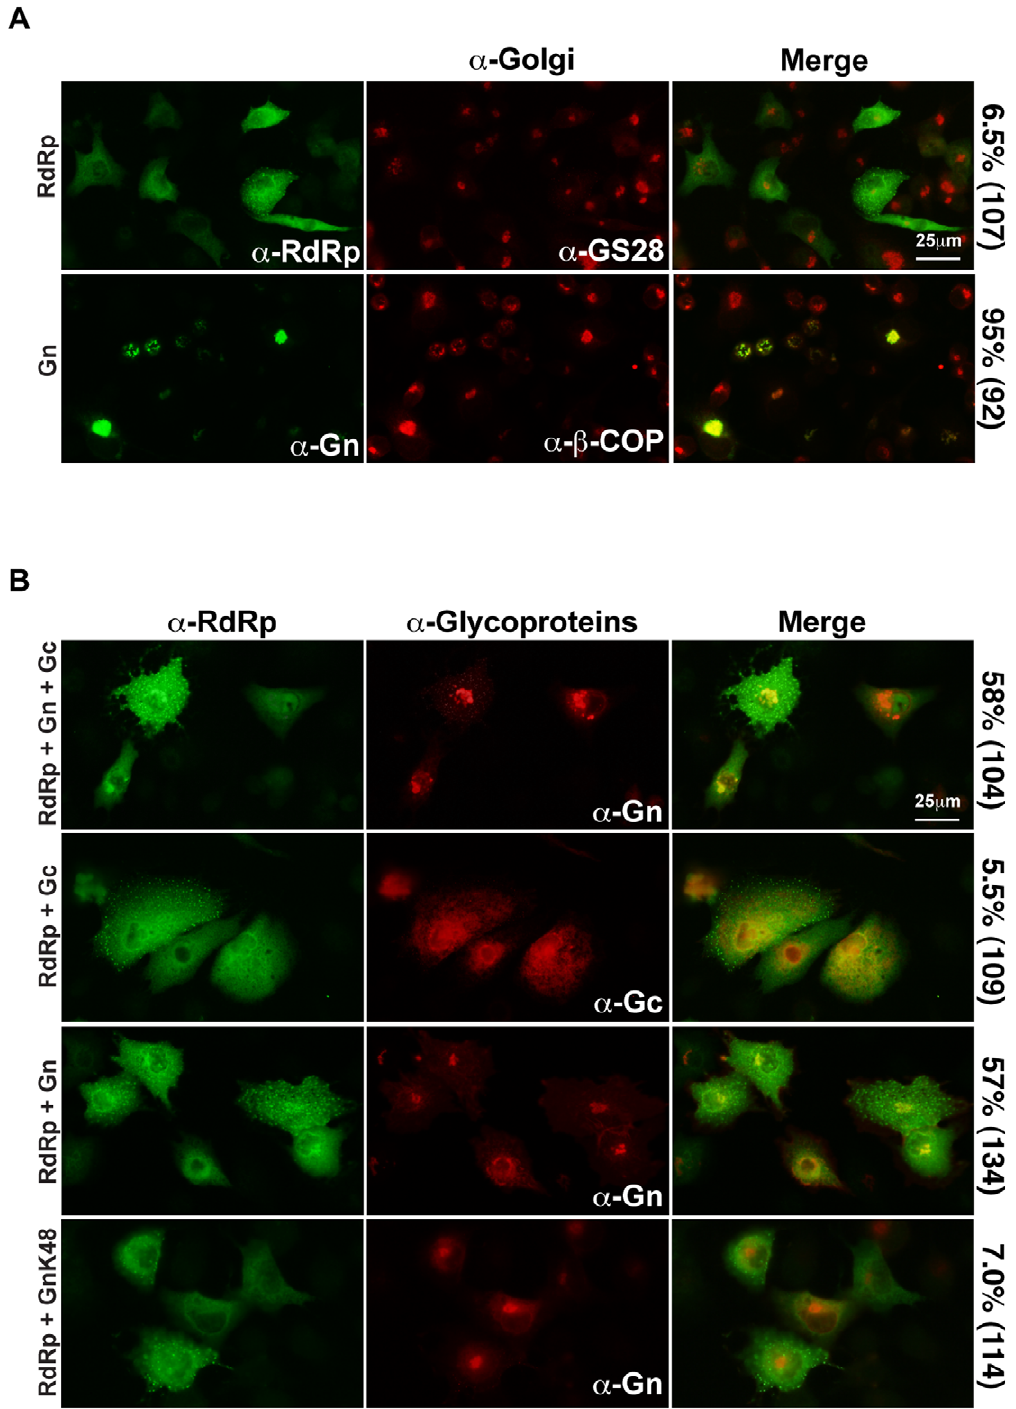
Figure 3. Gn recruits RdRp. A. BSR-T7/5 cells were transfected with pRdRp or pGn, and the proteins were visualized with anti-RdRp and anti-Gn, respectively (green channel). Cellular resident Golgi apparatus proteins, GS-28 or b -COP were also labeled (red channel). Percentage of cells displaying co-localization of viral proteins with resident Golgi proteins is indicated with the number of cells counted in parentheses. B. BSR-T7/5 cells were transfected with pRdRp and either pGn/pGc, pGc, pGn, or pGnK48. Cells were incubated with anti-RdRp (green channel) and anti-Gn or anti-Gc (red channel), and then analyzed by immunofluorescence microscopy. Percentage of cells displaying co-localization of RdRp with Gn or Gc is indicated with the number of cells counted in parentheses.